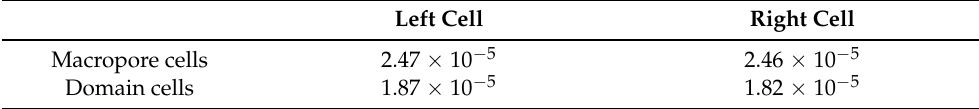
Table 2. Model liquid phase velocity results [m s − 1 ] for scenario (c) of Forchheimer–Case 1. Left Cell Right Cell